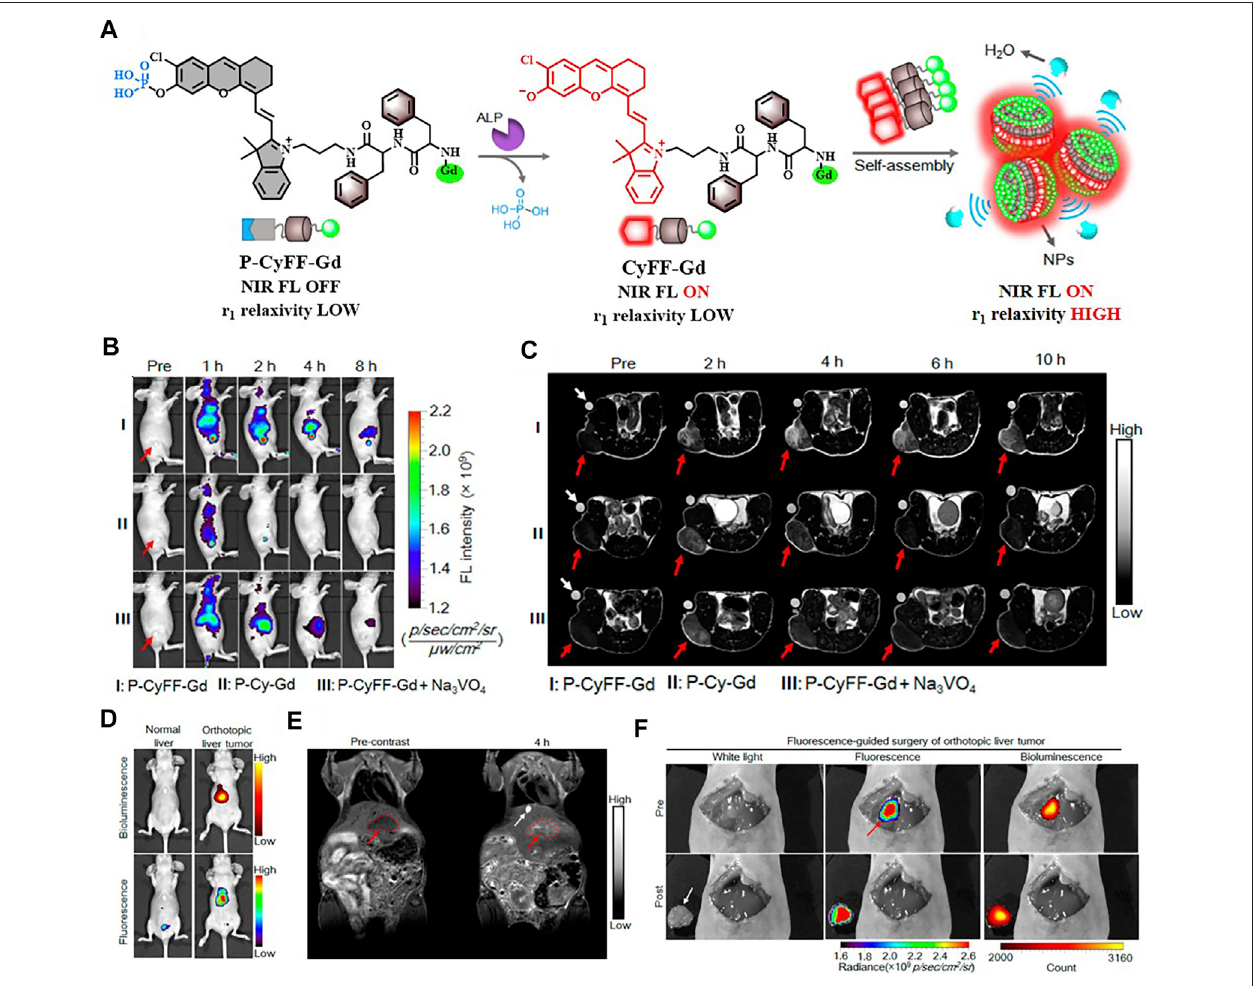
FIGURE10 | (A) Schematic illustration of P-CyFF-Gd in situ self-assembly. (B) Longitudinal FI ofmice after various treatmentsis indicated. (C) T 1 -weighted MRI of HeLatumor-bearingmicereceivingdifferenttreatments. (D) Whole-body fl uorescence(down)andbioluminescence (up)imagingofnormalmiceandorthotopicHepG2/ Luclivertumorxenograftmicefollowingi.v.injectionofP-CyFF-Gd(50 μ M,200 μ l)at4 h (E) T 1 -weightedMRIoforthotopicHepG2/Luclivertumorxenograftmicebefore andafteri.p.injectionofP-CyFF-Gd(0.015 mmol/kg). (F) Imaging-guidedsurgicalresectionoforthotopicHepG2/Luclivertumorinanintraoperativemouse30 min after directly spraying P-CyFF-Gd (10 μ M) on the liver. Reproduced with permission from Yan et al. (2019). Copyright 2019, American Chemical Society.